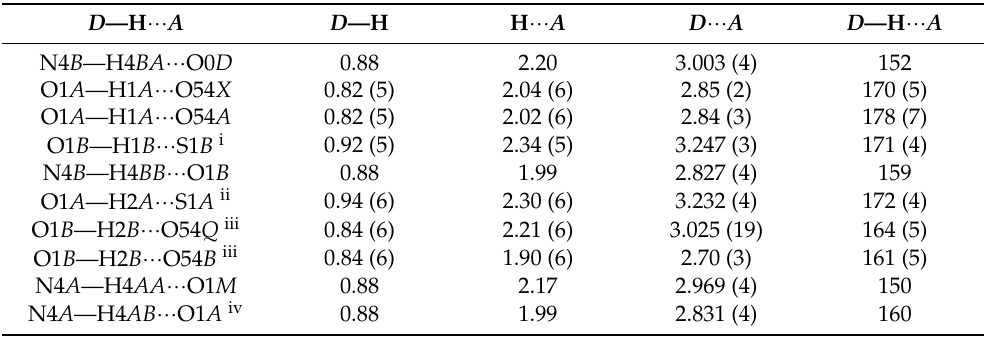
Table 6. Hydrogen-bond geometry (Å, ◦ ) for 4 .